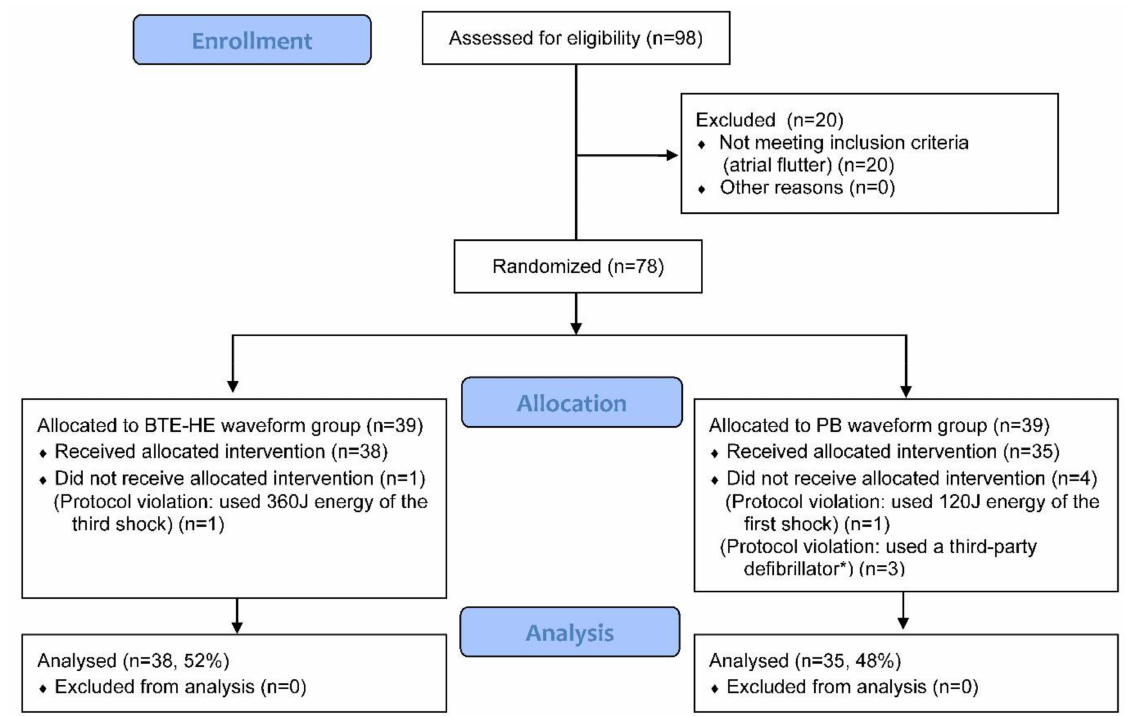
Figure 2. CONSORT flowchart of patient enrollment, allocation and analysis. * The third-party defibrillator was DEFIGARD 4000 (Schiller M é dical, Wissembourg, France), embedding the pulsed biphasic